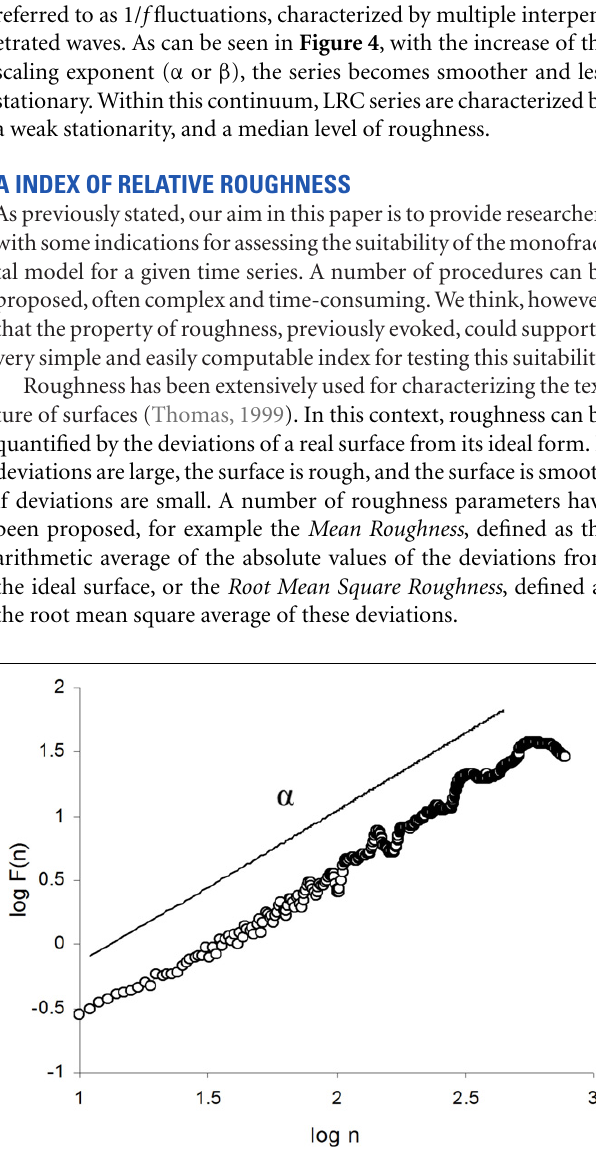
FIGURE 3 | Detrended FluctuationAnalysis. The exponent α is determined as the slope of the log–log diffusion